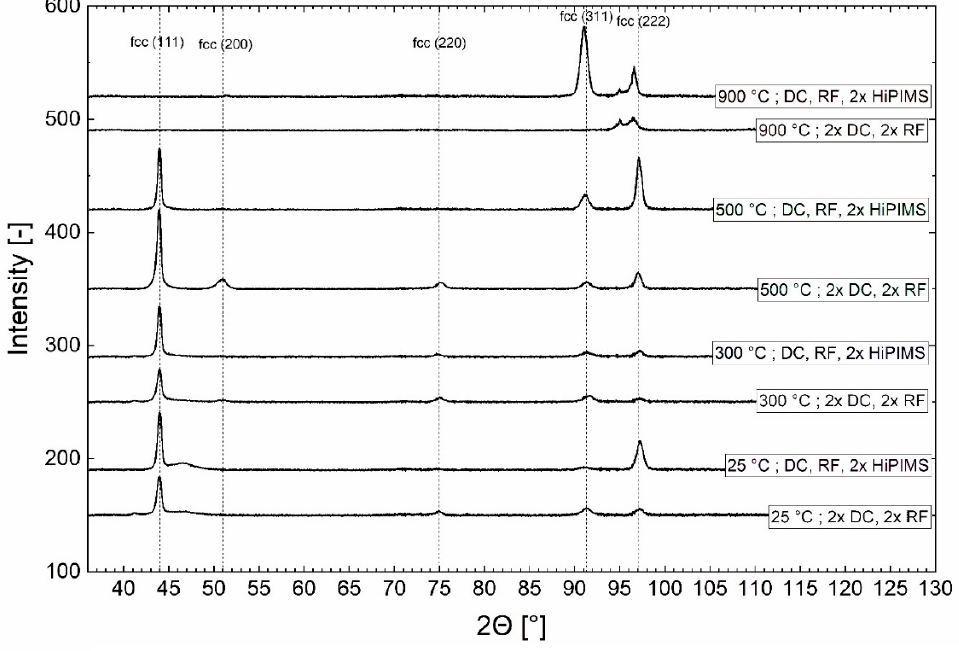
Figure 1. Results of XRD for eight as-deposited CrCoFeNi films deposited at substrate temperatures of 25, 300, 600, and 900 °C with two different power supply arrangements, indicating fcc crystal structure.